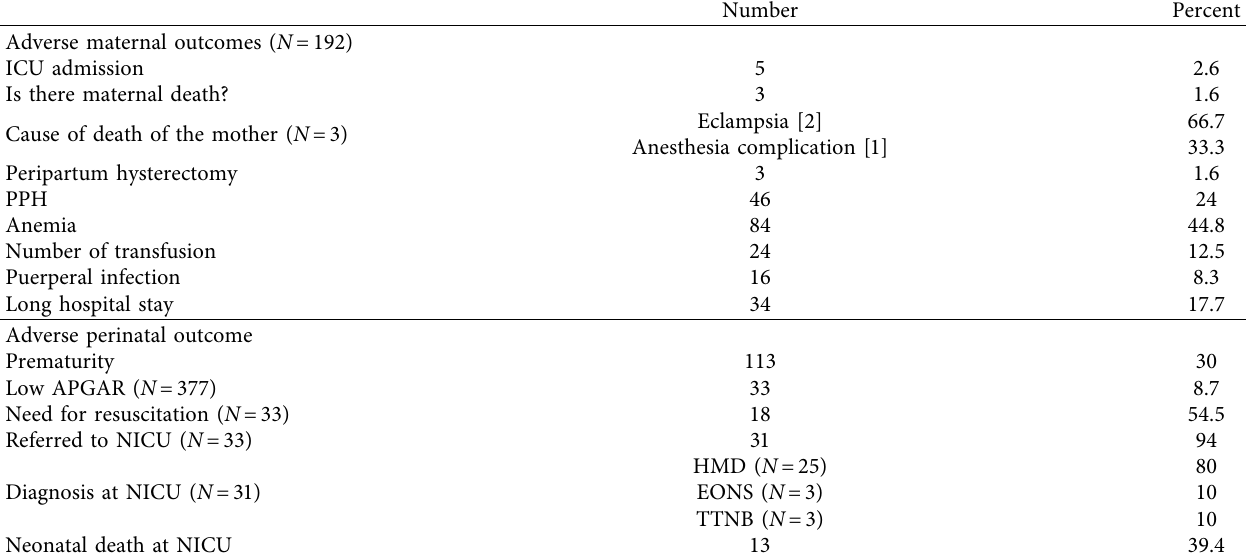
Table 5: Frequency and distribution of adverse perinatal and maternal outcomes.